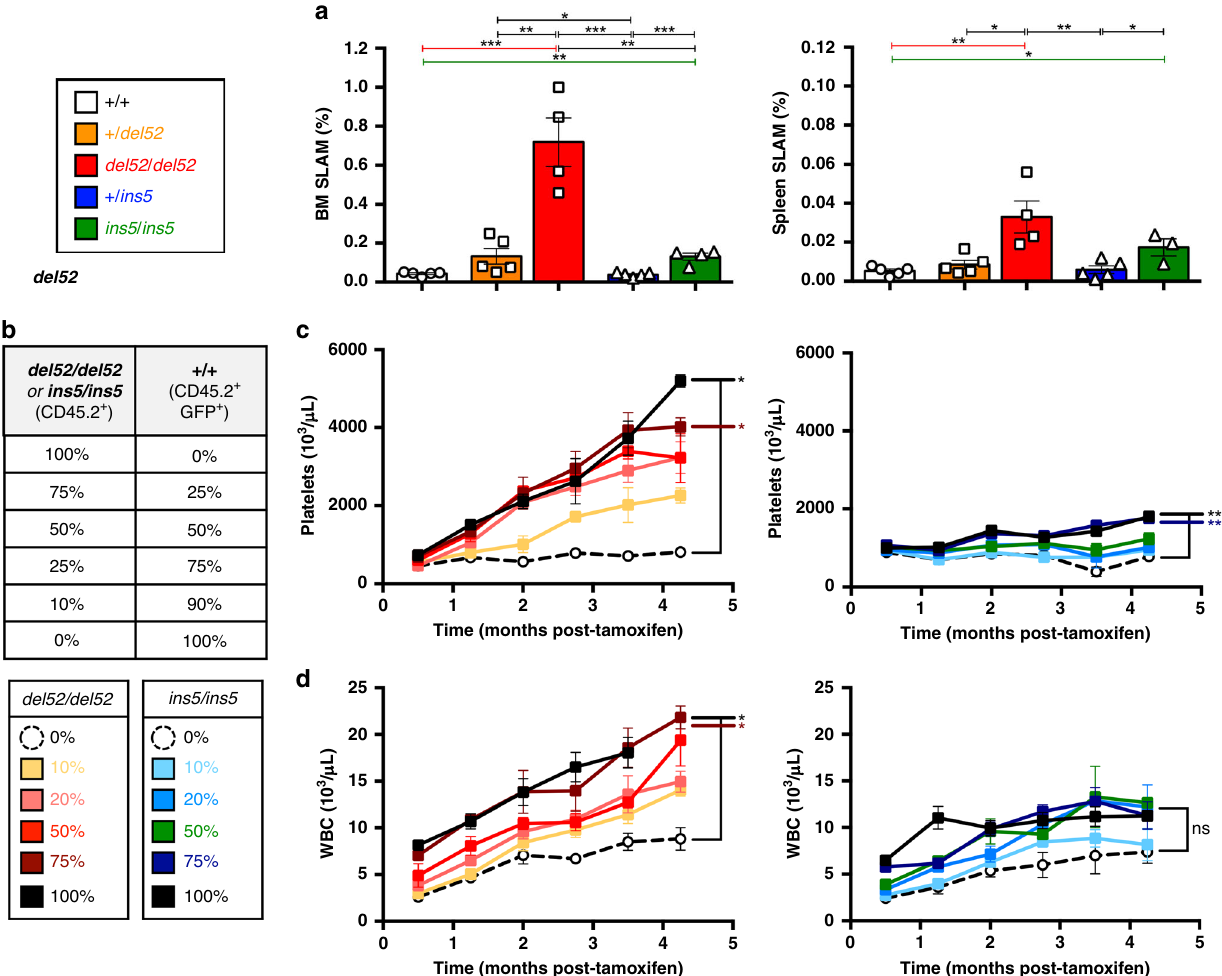
Fig. 6 Effect of CALR del52 and CALR ins5 on the HSCs. a Percentages of HSCs (SLAM, Lin − c-Kit + Sca- + CD150 − CD48 + ) in BM and spleen of ≥ 10 months post-tamoxifen mice were expressed as means± SEM ( n = 5 independent mice of + / + (white), + /del52 (orange) and + /ins5 (blue) genotypes; n = 4 del52/del52 (red) mice and for ins5/ins5 (green) genotype n = 4 for BM and n = 3 for spleen analyses). Signi fi cance was determined using a two-sided parametric t -test: in BM, * p = 0.047; ** p = 0.0012 ( + / + vs. ins5/ins5 ), 0.0016 ( + /del52 vs. del52/del52 ), 0.0034 ( del52/del52 vs. ins5/ins5); *** p = 0.0004 except 0.0009 for + /ins5 vs. ins5/ins5 and in spleen, * p = 0.0157 ( + /del52 vs. del52/del52 ), 0.0131 ( + / + vs. ins5/ins5 ); ** p = 0.0071 ( + / + vs. del52/del52 ), 0.0094 ( del52/del52 vs. + /ins5 ), 0.0334 ( + /ins5 vs. ins5/ins5 ). b To investigate the effect of CALR del52 and CALR ins5 on HSCs we engrafted different ratios of homozygous del52/del52 (yellow, pink, red, brown and black squares and solid lines) and ins5/ins5 (turquoise, blue, green, dark blue and black squares with solid lines) CD45.2 + KI BM cells with wild-type ( + / + ) CD45.2 + GFP + BM cells in CD45.1 + lethally irradiated mice. Four weeks after transplantation, KI allele expression was induced by tamoxifen and c platelet and d WBC counts were measured. Data are the means ± SEM, del52/del52 platelets: n = 4, 4, 2, 4, 4, 3 for 0%, n = 4, 4, 3, 3, 3, 3 for 10%, n = 5, 4, 5, 4, 4, 4 for 25%, n = 5, 5, 4, 5, 5, 4 for 50%, n = 3, 4, 4, 3, 4, 3 for 75% and n = 5, 5, 5, 3, 5, 2 for 100%; ins5/ins5 platelets: n = 3, 3, 3, 1, 3, 3 for 0%, n = 5, 4, 3, 4, 2, 4 for 10%, n = 5, 5, 5, 4, 2, 3 for 25%, n = 5, 5, 3, 4, 3, 5 for 50%, n = 5, 5, 3, 4, 3, 5 for 75% and n = 5, 5, 3, 4, 4, 5 for 100%; del52/del52 WBC: n = 4, 4, 3, 4, 4, 4 for 0%, n = 4 for 10%, n = 5, 4, 5, 5, 4, 5 for 25%, n = 5, 5, 5, 5, 5, 4 for 50%, n = 4, 4, 4, 3, 4, 4 for 75% and n = 5, 5, 5, 4, 5 for 100%; ins5/ins5 WBC: n = 3, 3, 3, 2, 3, 3 for 0%, n = 5, 5, 4, 4, 5, 5 for 10%, n = 5, 5, 5, 5, 3, 4 for 25%, n = 5, 5, 5, 5, 3, 5 for 50%, n = 5, 5, 3, 5, 4, 5 for 75% and n = 5, 4, 5, 5, 5, 5 for 100%. N represents individual mice and varies depending on time of sampling during the course of the experiment and on the group de fi ned as the percentage of engrafted homozygous cells, as indicated in the Source data fi le. Signi fi cance compared to the 0% condition (open circles with connecting black dashed line) was determined using ANOVA with Dunnett ’ s multiple comparison test and a nonparametric Kruskal – Wallis ’ s multiple comparison test for ins5/ins5 WBC. In c , * p = 0.0172 (100%), 0.0256 (75%); *** p = 0.0001 (100% and 75%) and in d , * p = 0.0422 (100%), 0.0128 (75%); ns not signi fi cant. Source data are provided as a Source data fi